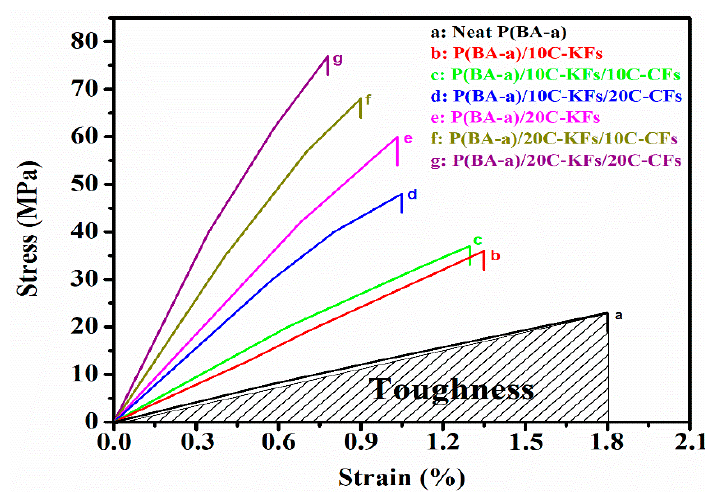
Figure 7. Tensile stress/strain curves of the P(BA-a)/C-KFs/C-CFs composites.